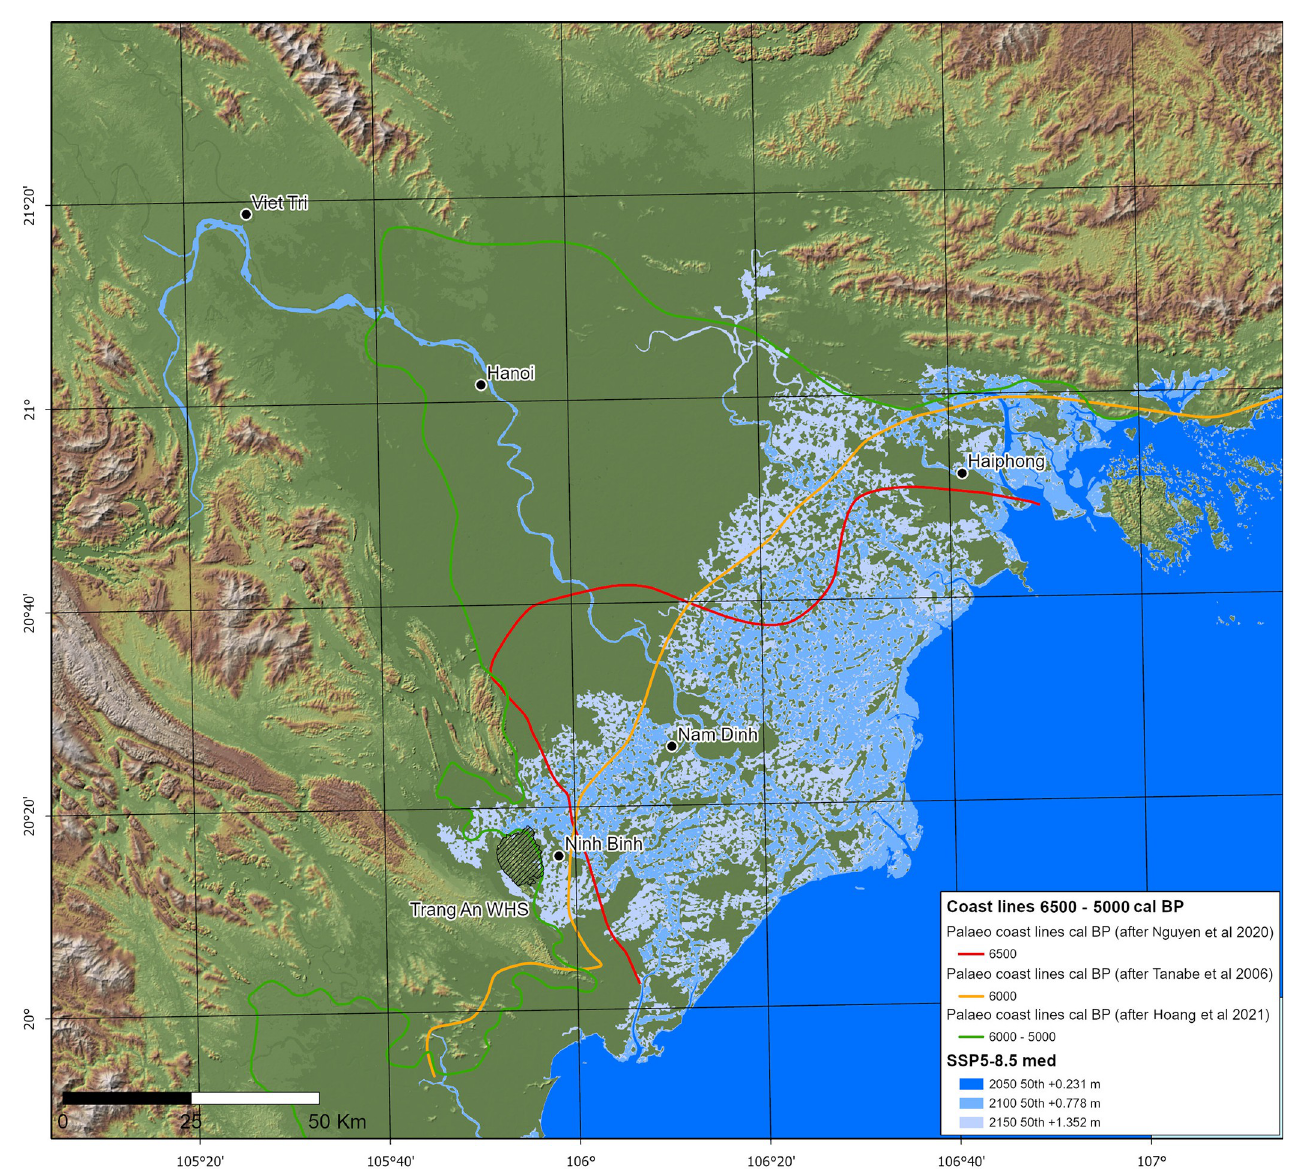
Fig 4. SSP5–8.5 (med. confidence) sea level rise models contrasted with Mid-Holocene coastlines. CoastalDEM 1 courtesy of Climate Central (https://go. climatecentral.org/coastaldem/). Projected sea levels were obtained via the NASA IPCC AR6 Sea Level Projection Tool (https://sealevel.nasa.gov/data_tools/17) (Image: Thorsten